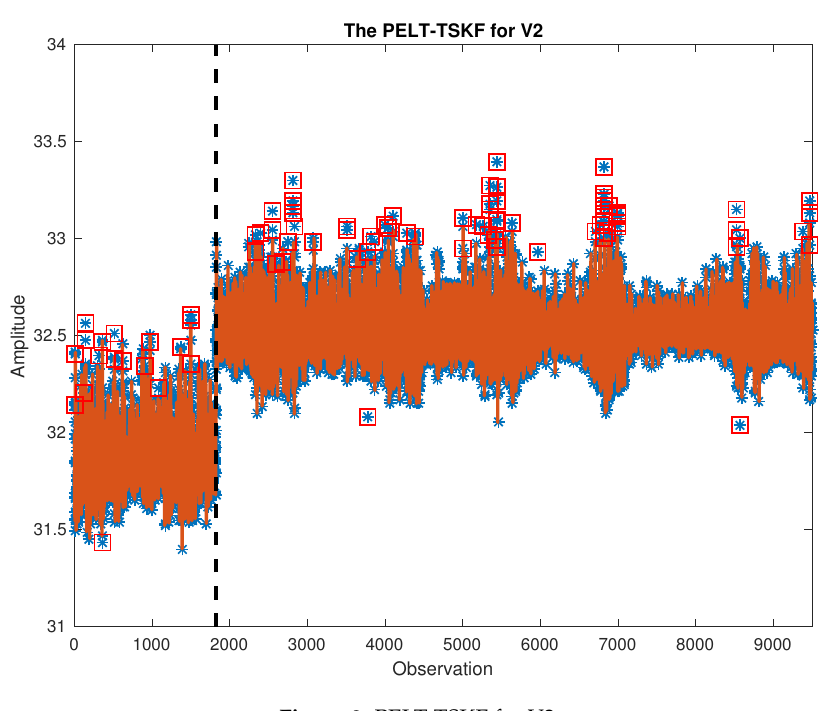
Figure 9. PELT-TSKF for V2.